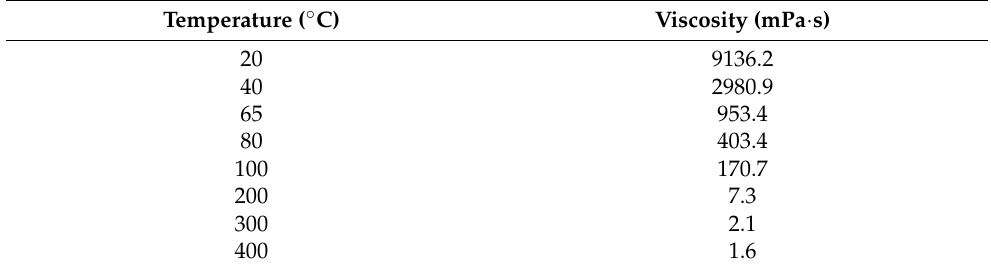
Table 5. Viscosity-temperature relationship [30].